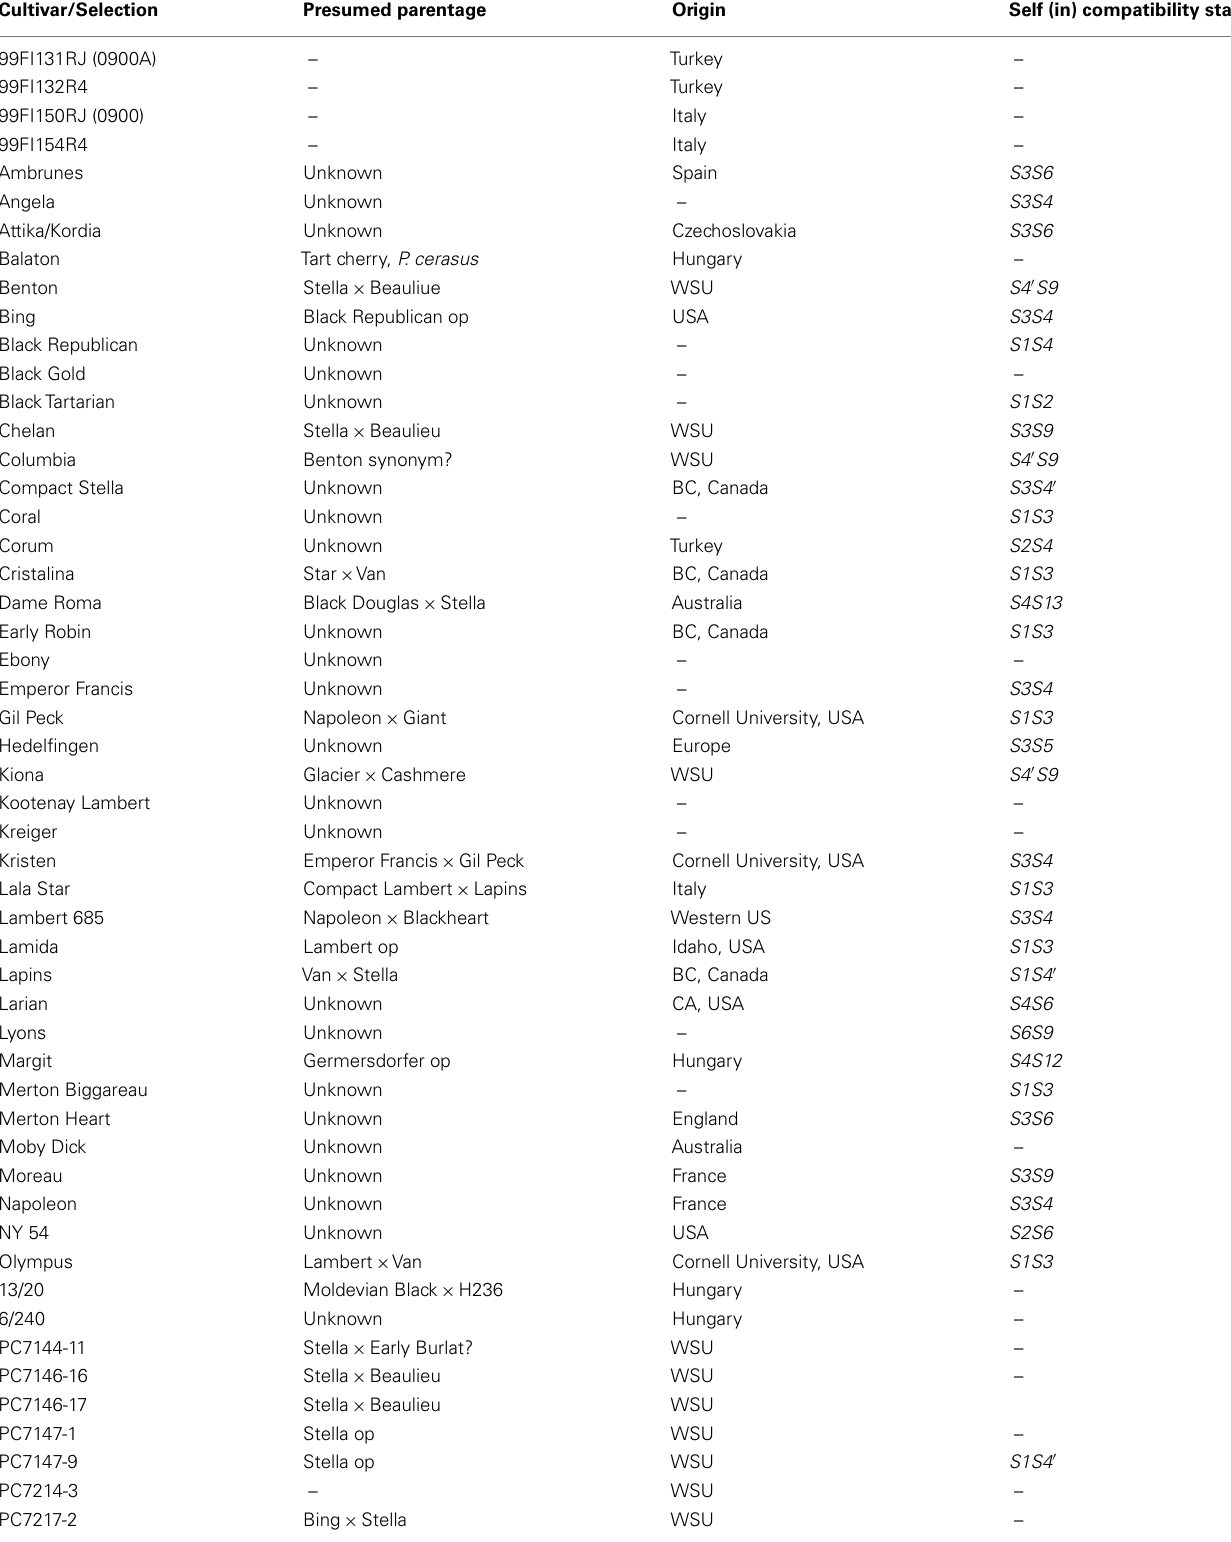
Table 1 | Sweet cherry accessions, presumed parentage, origin, and self (in) compatibility status.